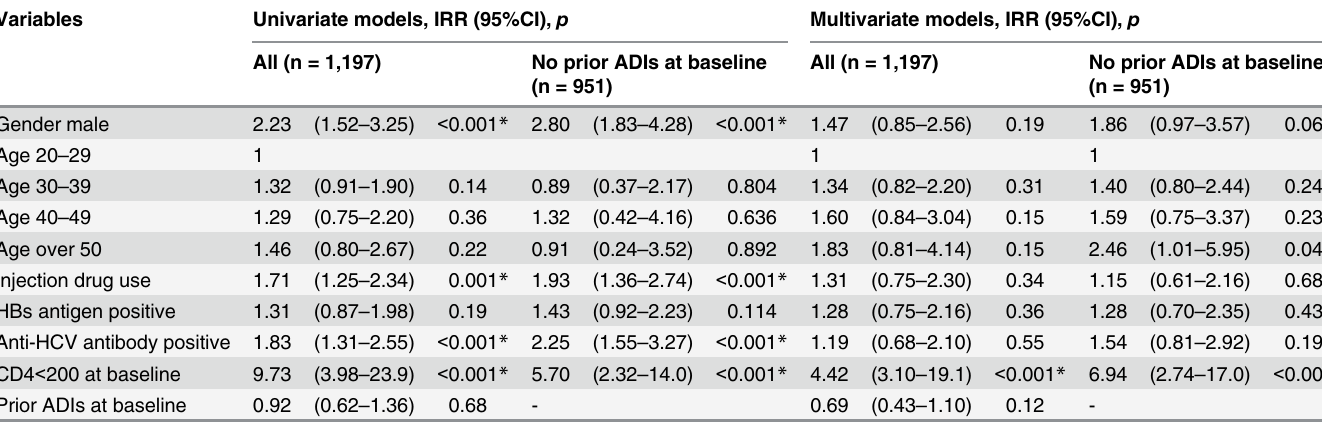
Table 3. Factors Associated with Acquiring AIDS-Defining Opportunistic Infections during